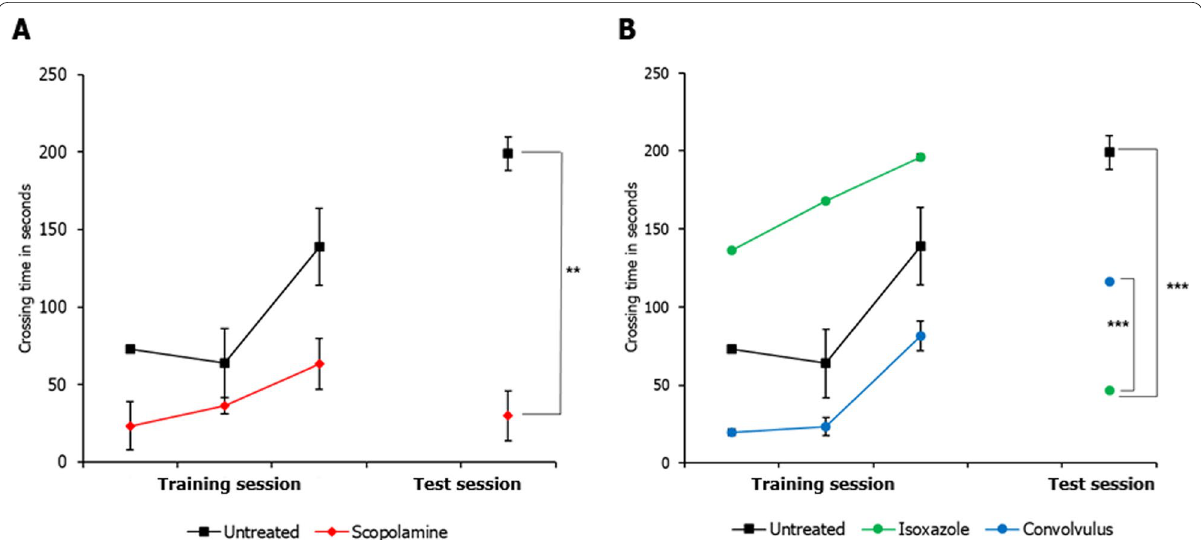
Fig. 5 Effect of test compounds on the acquisition of avoidance response. Comparison of the crossing times of A control untreated and scopolamine (SCOP)-treated adults and B adults treated with isoxazole (ISOX) and Convolvulus pluricaulis (CP). The solid circles and squares represent the crossing times measured in the three training sessions and one test session, which was conducted 2 h after the training sessions. These crossing times have been expressed as mean standard deviation. Three independent experiments were conducted to determine the effects of SCOP, ± ISOX, and CP on the fishes, and in each of these experiments, at least 3–5 adult fishes were treated with the least toxic concentrations of SCOP (200 µM), ISOX (31.2 mM) and CP (11.4 mg/ml). The fishes were treated with the AChE inhibitor (i.e. ISOX or CP) one hour before treatment with SCOP. *, **, and *** indicate p-value < 0.5, < 0.01 and < 0.001 of two-tailed unpaired t-test for untreated versus test groups (in most cases, unless indicated otherwise)